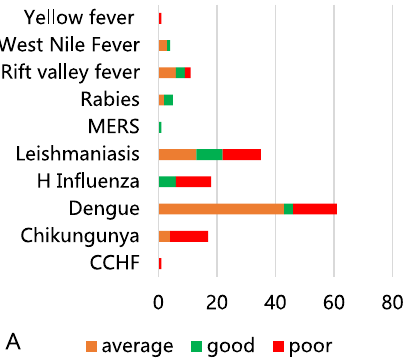
of papers that had the data on these measures for specific diseases; diseases which did not have papers with relevant data are not shown. CCHF Crimean–Congo hemorrhagic Fever, MERS Middle East Res- piratory